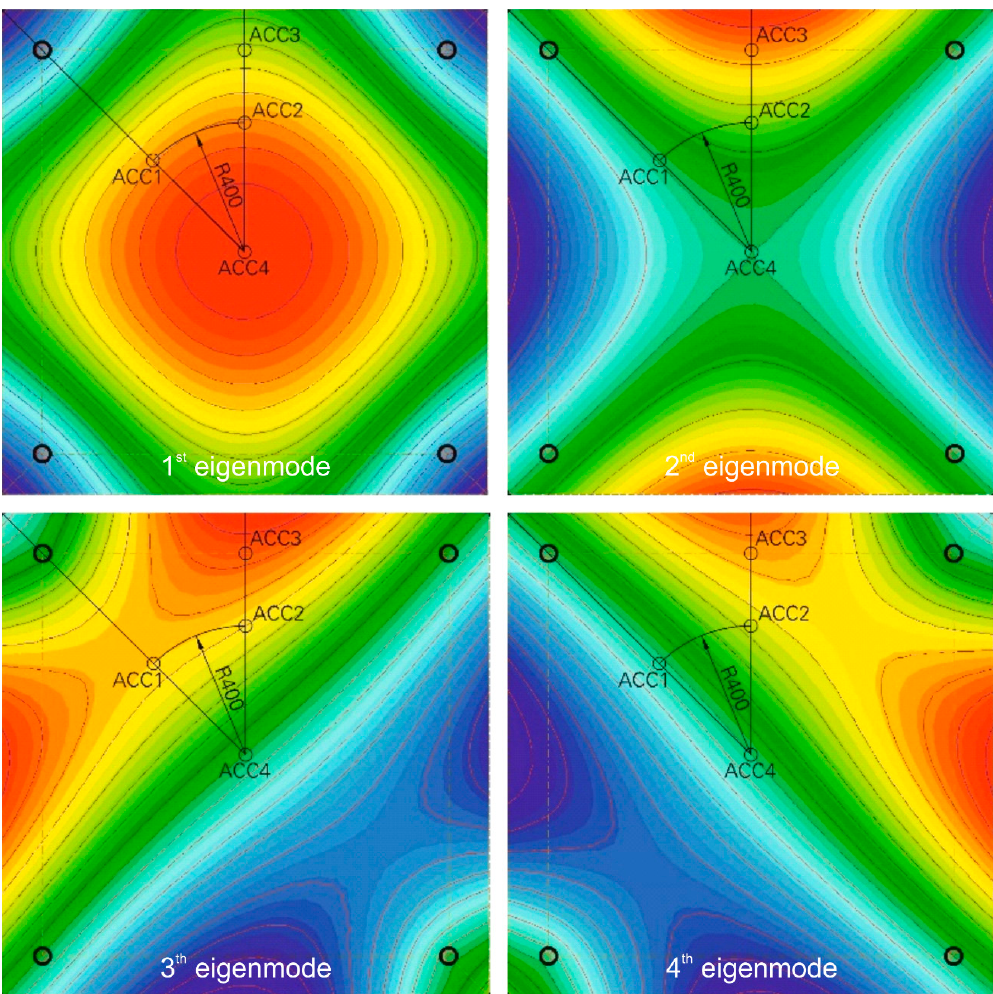
Figure 6. Eigenmodes of the reference RC plate with a four-point support in the corners according to Figure 4; graphic: Hering [17].